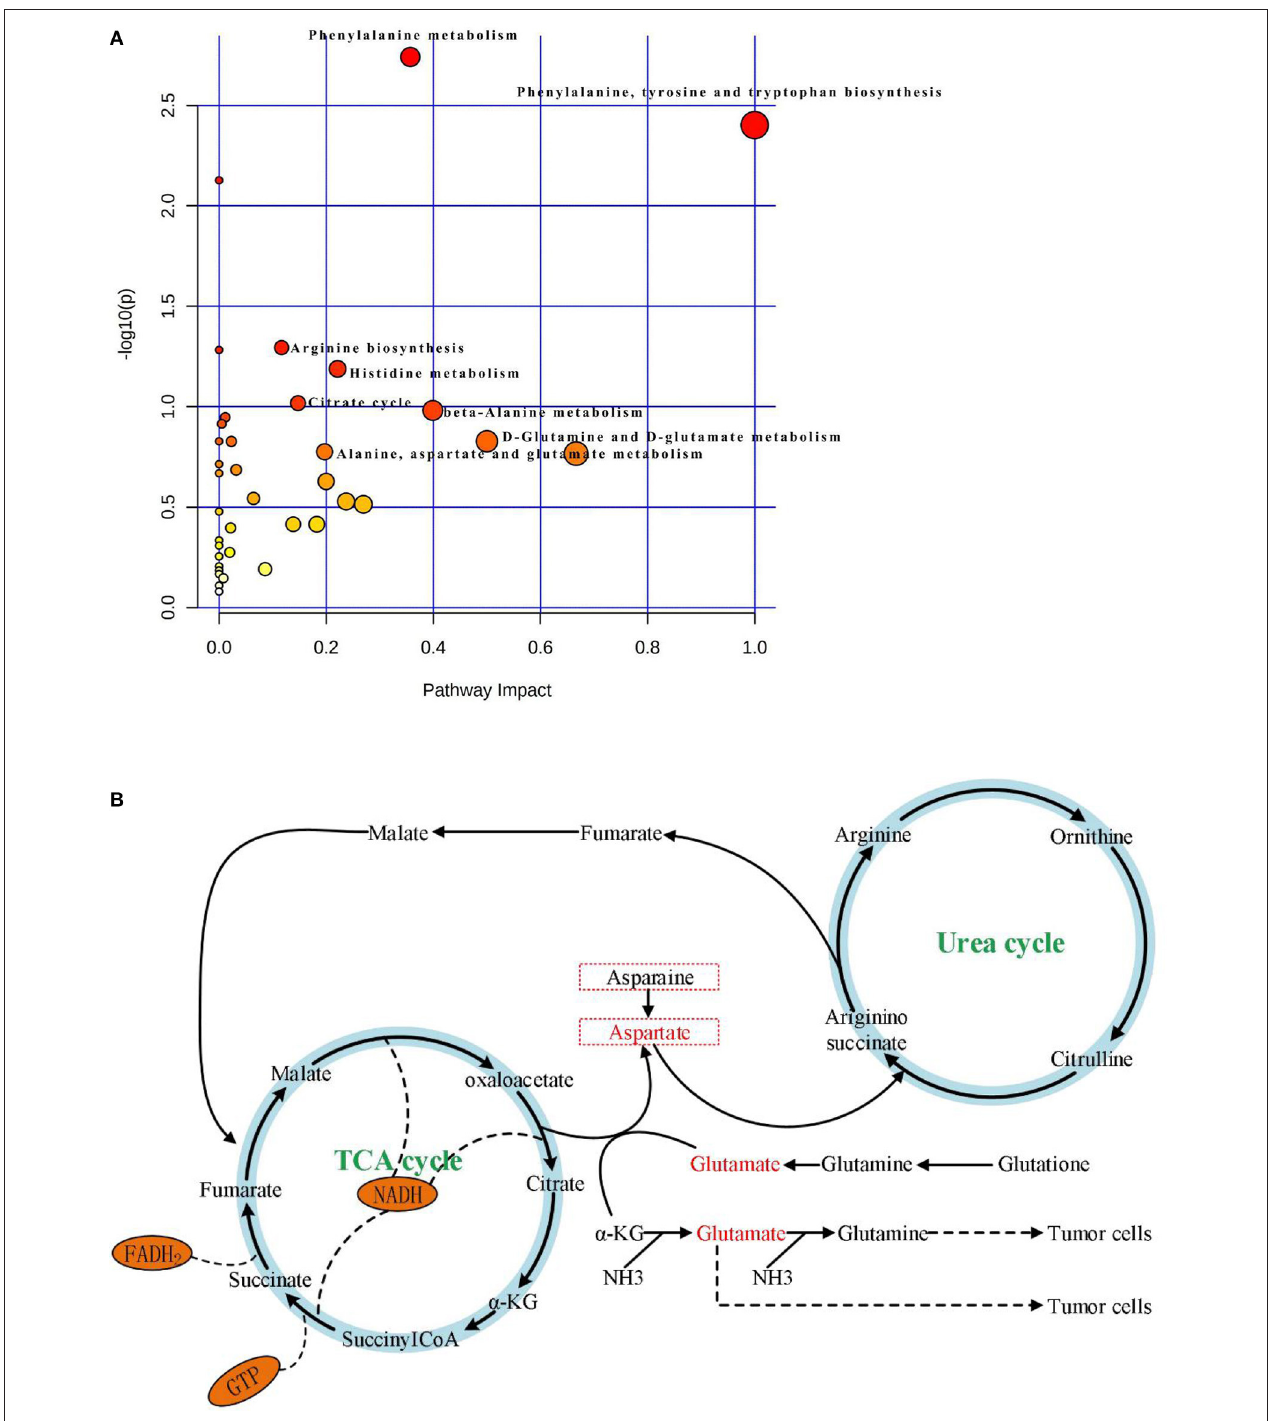
FIGURE 3 | (A) Results of pathway analysis of metabolomics data. Pathway analysis based on “Kyoto Encyclopedia of Genes and Genomes” (KEGG).The color and size of each circle is based on p- values (yellow: higher p- values and red: lower p- values) and pathway impact values (the larger the circle the higher the impact score) calculated from the topological analysis, respectively. Pathways were considered significantly enriched if p < 0.05, impact > 0.1 and number of metabolite hits in the pathway > 1. PTC, papillary thyroid carcinoma. (B) The significantly enriched pathways involved in the pathogenesis of papillary thyroid carcinoma, including Aspartate metabolism, Glutamate metabolism, Urea cycle, and TCA